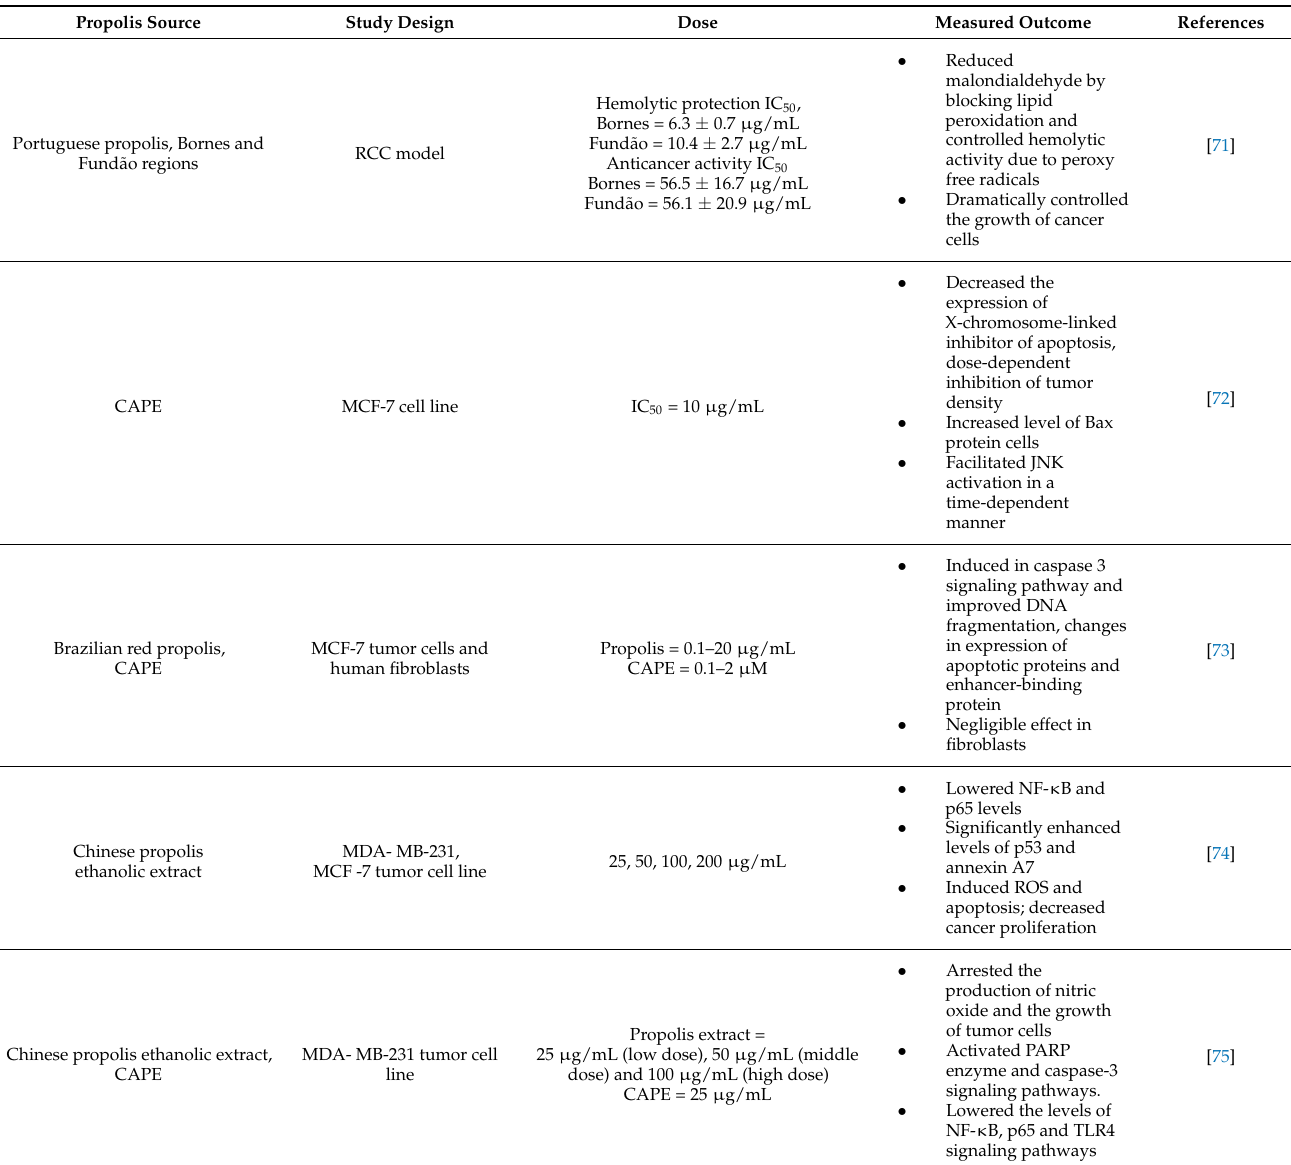
Table 5. Summary of clinical trials examining the activity of propolis and its constituents against